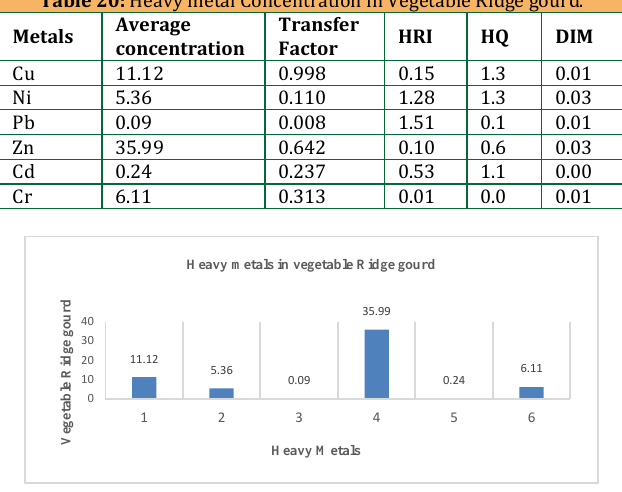
Figure 17: Average Concentration in vegetable Ridge gourd Spinach (5)